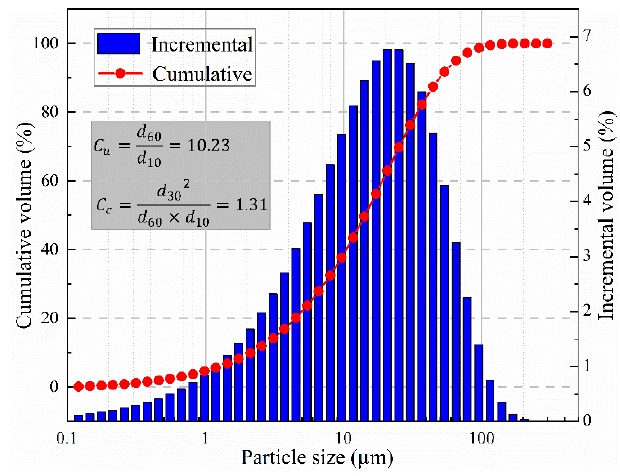
Figure 1. Particle size distribution of tailings. Table 1. The main chemical components of tailings.